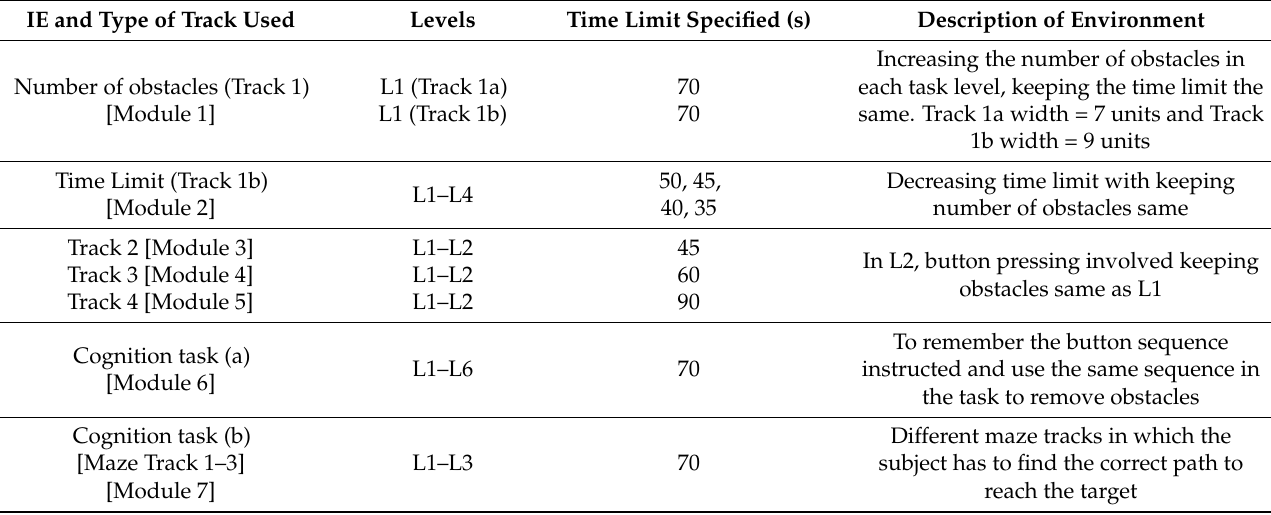
Figure 3. Representative shapes of various tracks used in designing VR tasks; black dot: starting position of the car; red dot: target position of the duck. Table 2. Description of task difficulty levels in